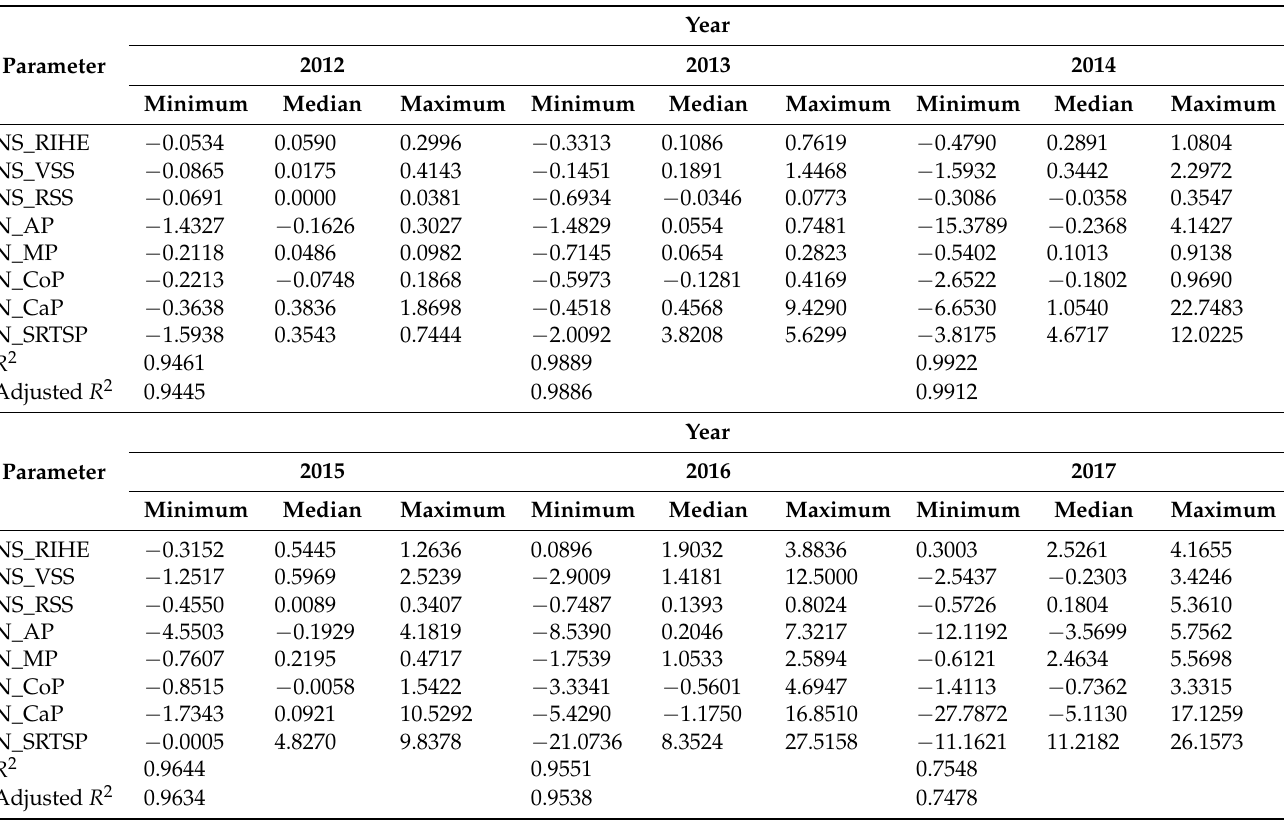
Table 2. The estimation results of the GWR